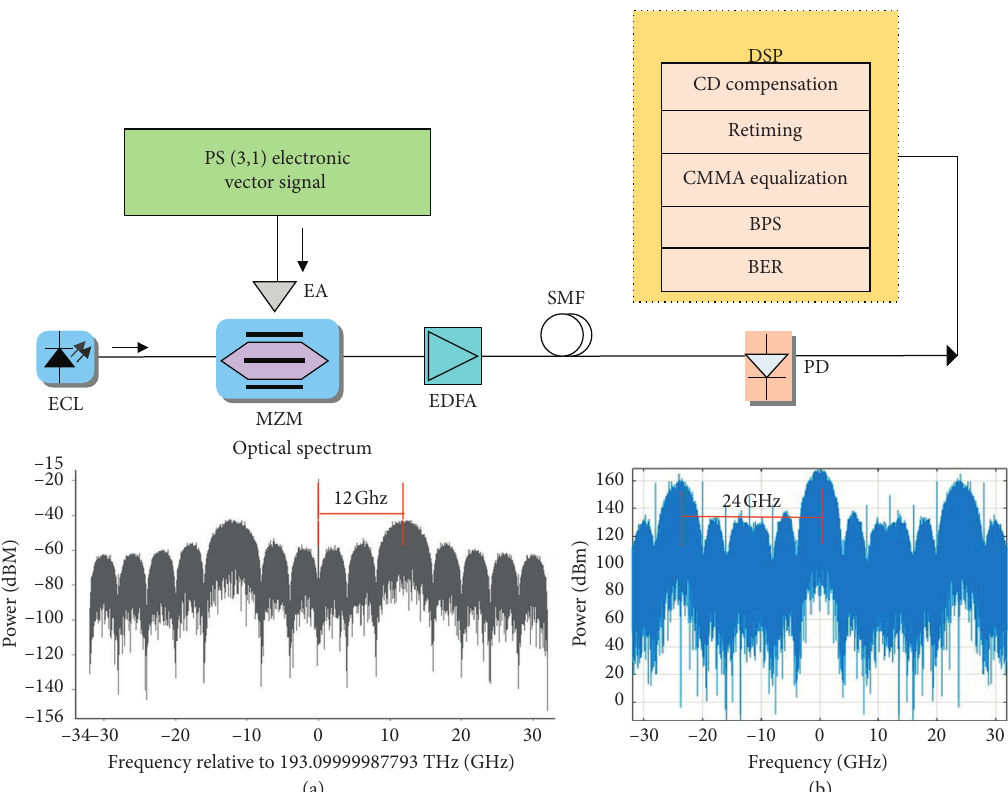
Figure 4: PS (3, 1) vector signal system diagram: (a) spectrogram of the PS (3, 1) photonic vector signal with v � 0.4 at 12GHz after MZM; (b) spectrogram of the PS (3, 1) vector signal with v � 0.4 after